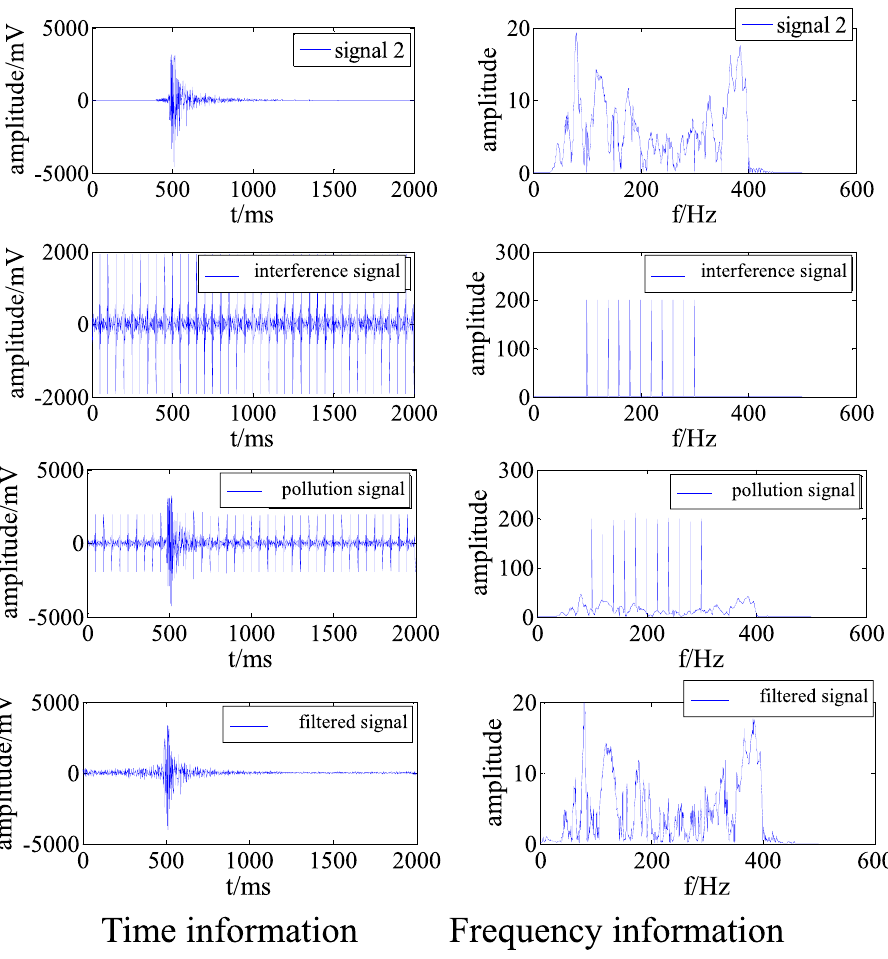
Figure 7. Time and frequency information of a signal polluted by multi-frequency interference before and after filtering.